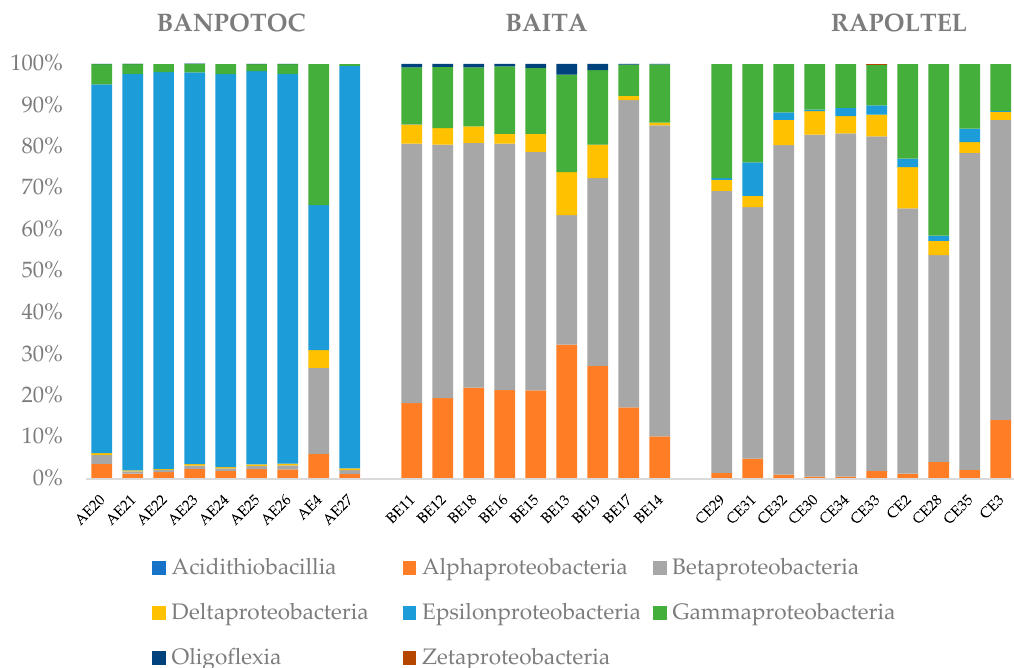
Figure 4. The relative abundance of the Proteobacteria classes in the analyzed membranes, showing the dominance of Epsilonproteobacteria (blue) in Banpotoc and of Betaproteobacteria (grey) in Baita and Rapoltel.